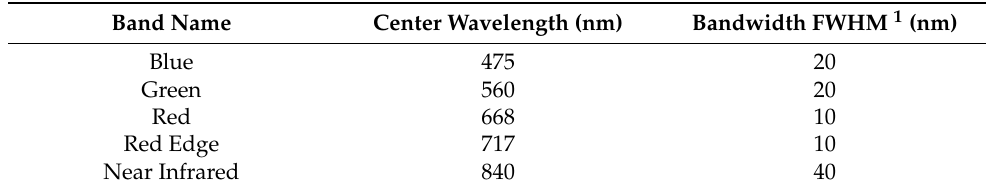
Table 2. MicaSense RedEdge-M camera spectral bands used for quantifying reflectance from table beet canopies in New York, USA, 2018 and